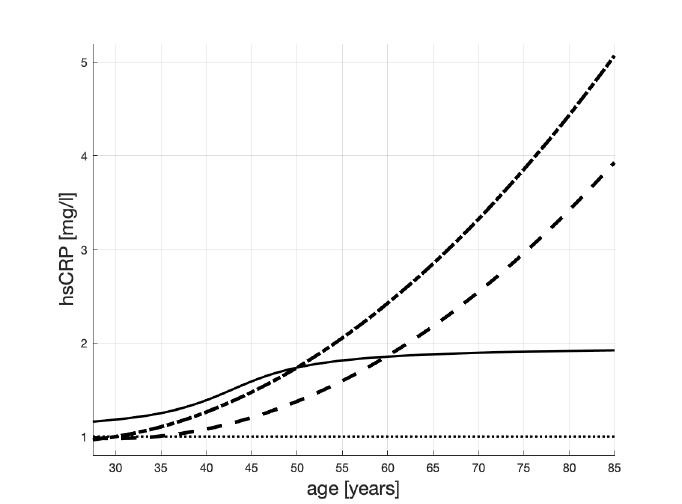
Figure 3. Hypothetical hsCRP scenarios of 3 male patients with different health histories. The dashed line is for a patient who is healthy until his mid-thirties when the levels of hsCRP start growing slowly ; the dash-dotted line is for a patient who is healthy until his mid-thirties when the levels of hsCRP start growing rapidly ; the solid line is for a male patient representative of an increased-risk group since young (hsCRP > 1 mg/L) and his health worsens after he turns 30; however, when he is about 45, his hsCRP stabilizes because of lifestyle changes.